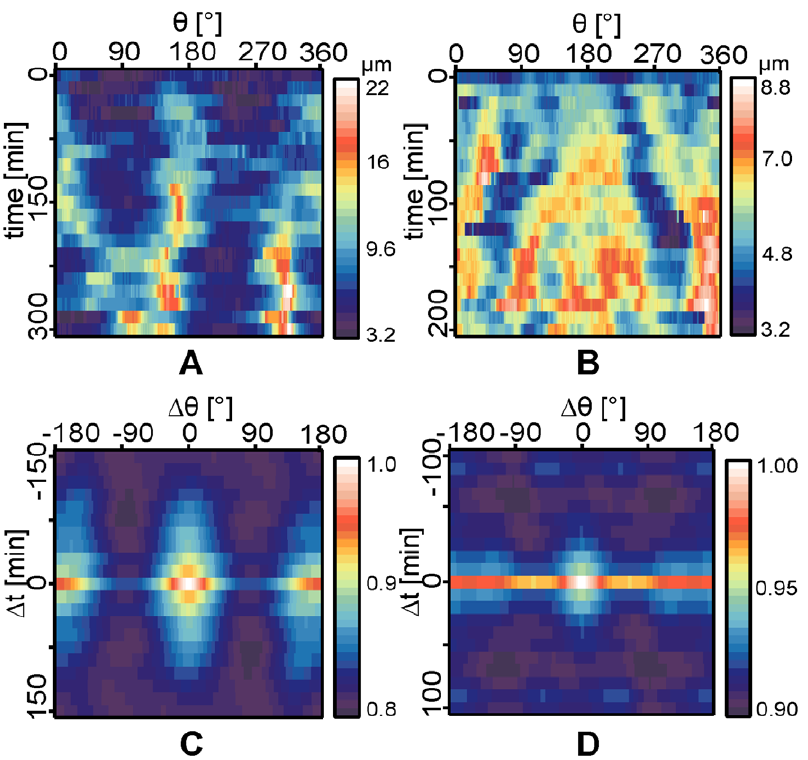
Figure 5. Cell shape fluctuation amplitude and autocorrelation map at early stage. Representative amplitude R ( h , t ) maps of (A) 1AS and (B) ASpSV14 cells plotted as function of h recorded during the early stage of cell adhesion ( t = 0–200 min). The corresponding autocorrelation functions for 1AS and ASpSV14 are presented in panel (C) and (D), respectively.